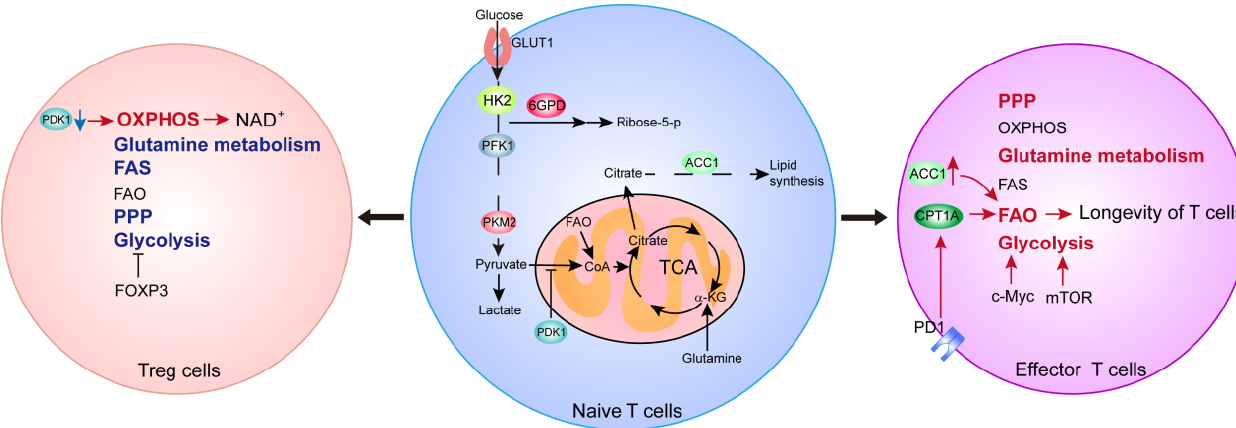
Figure 3. Overview of cellular metabolic pathways in various T cell populations. The red arrows and text indicate enhanced metabolic processes, the blue arrows and text indicate suppressed processes, and the black arrows and text indicate baseline activities.